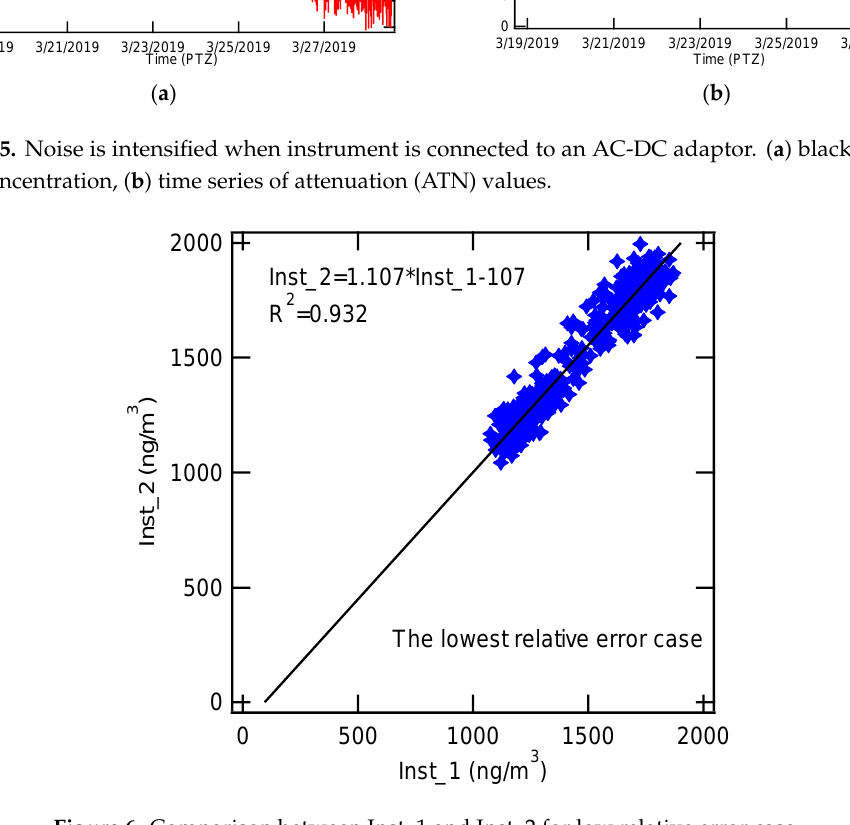
Figure 6. Comparison between Inst_1 and Inst_2 for low relative error case.